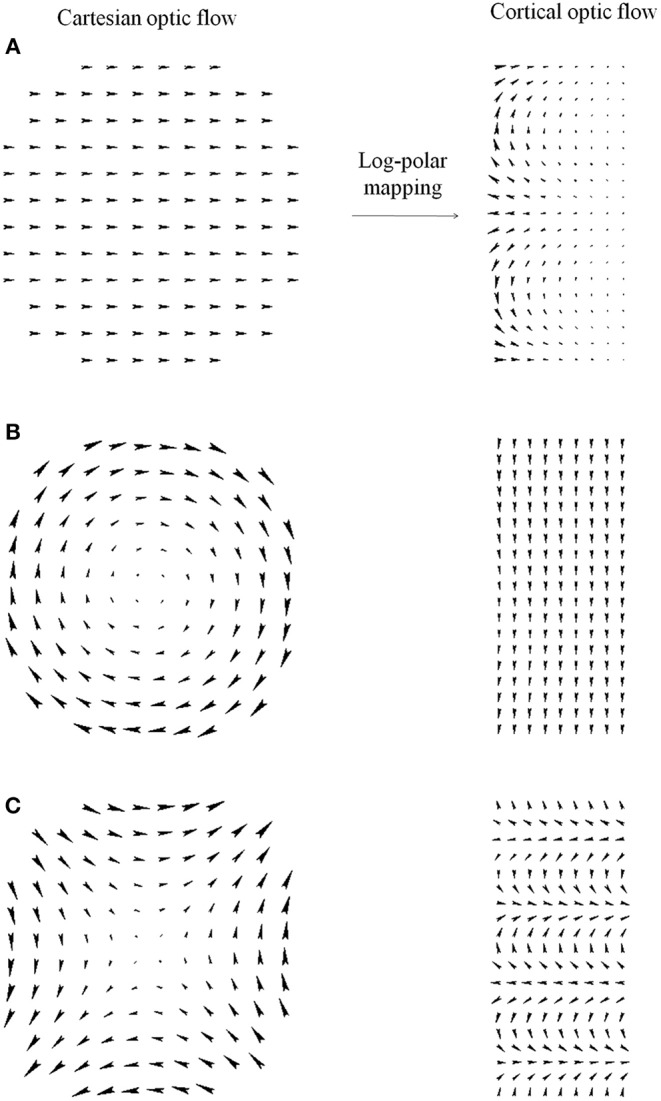
Optic flow patterns in the Cartesian and cortical domains: (A) constant, (B) rotation, and (C) shear optic flow pattern.